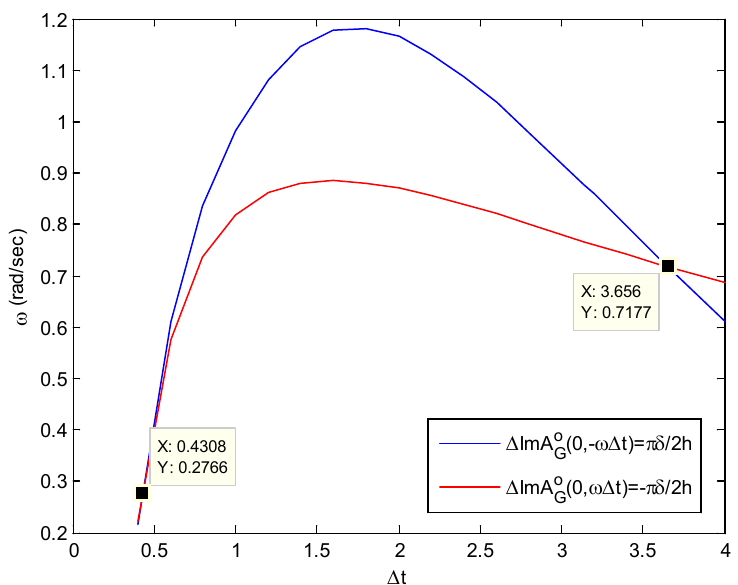
Figure 27. Plots of recorded values given in Table 4.